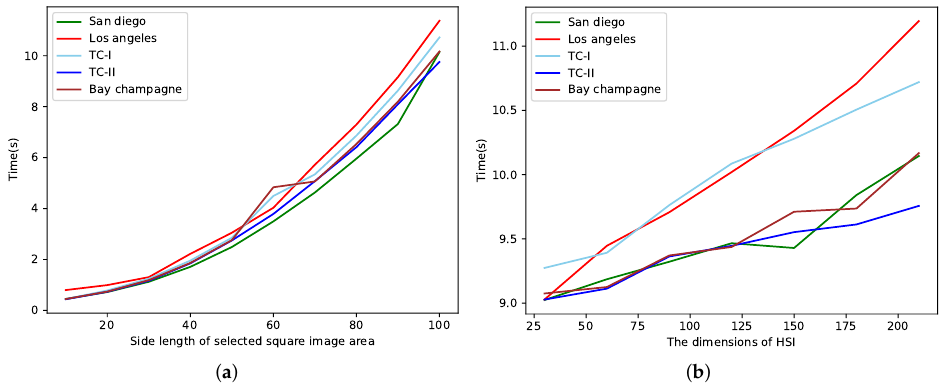
Figure 13. The processing time of the proposed BEGAIP varies with the HSI spatial size and spectral dimensions. ( a ) The processing time varies with the spatial size when the spectral dimensions are fixed. ( b ) The processing time varies with the spectral dimension when the spatial size is fixed.